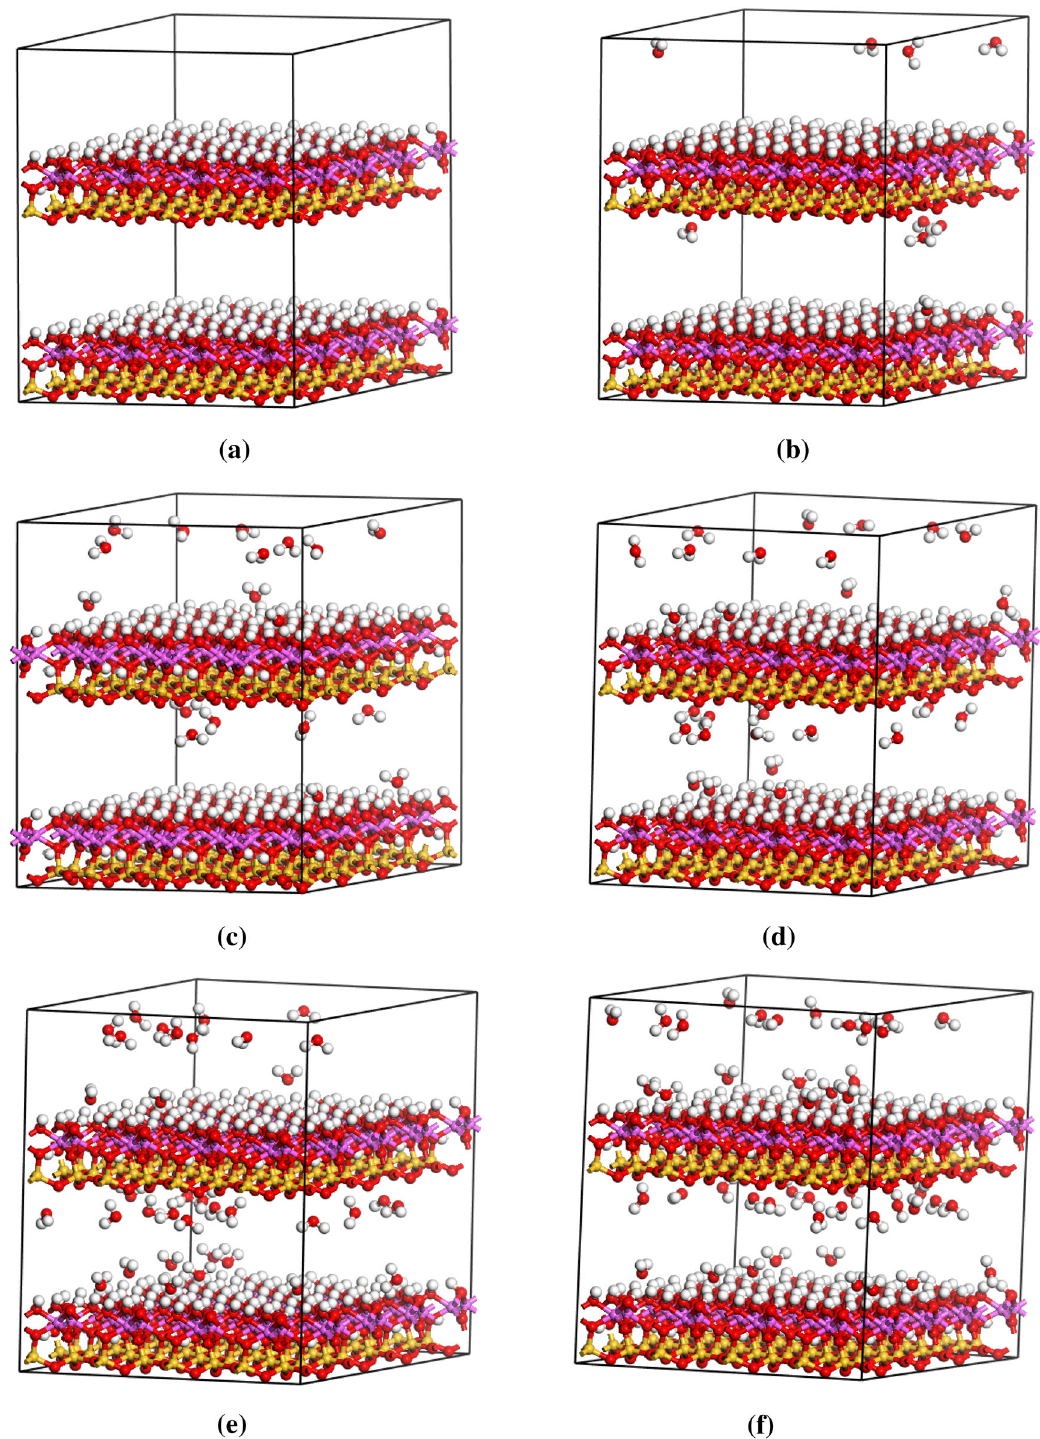
Fig. 1 Equilibrium configuration snapshot of kaolinite–H 2 O–CH 4 system with a 0%, b 1%, c 2%, d 3%, e 4%, and f 5% water